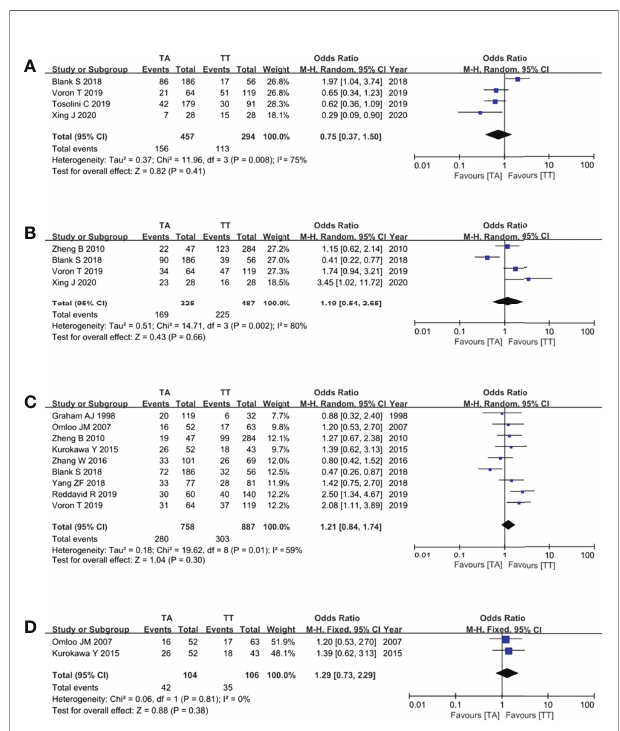
FIGURE 5 | Forest plots showing the assessment of oncological outcomes, namely, (A) overall recurrence rate, (B) 3-year OS rate, (C) 5-year OS rate, and